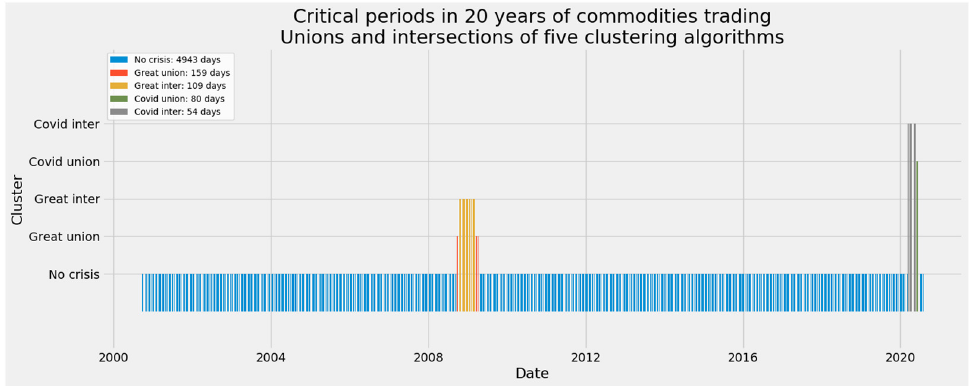
Figure 17. Set theory aggregations of temporal clusters—An ordered timeline.